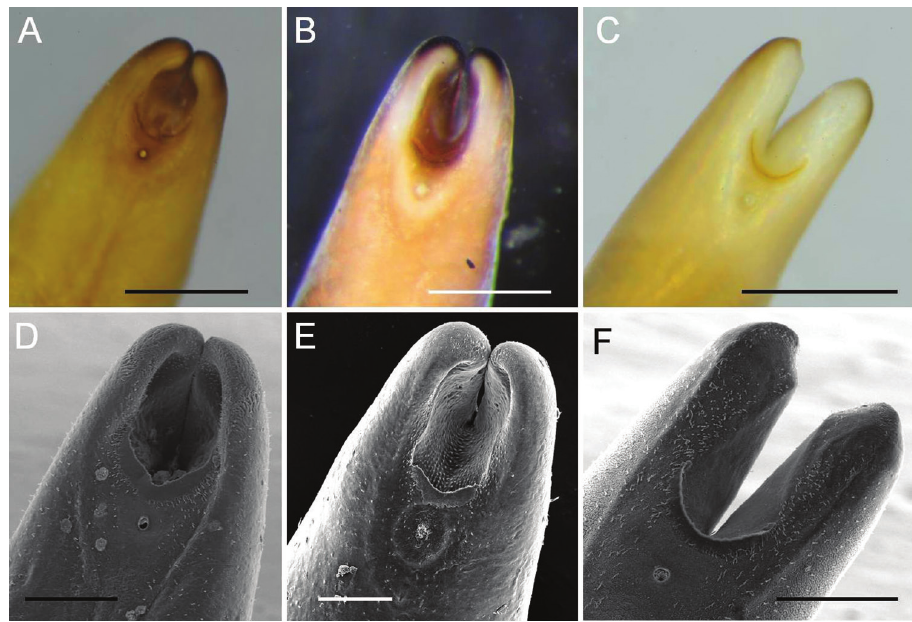
Figure 2. Posterior end of male Acutogordius taiwanensis sp. n. A–C Images of the posterior end with the postcloacal crescent extending A, C over or B anterior to the starting point of the tail lobe bifurcation D–F SEM images of the posterior end with a D angled E slightly curved, and F semicircular postcloacal cres- cent A–F are images from the same individual, respectively. Scale bars 500 µm ( A–C ), and 200 µm ( D–F